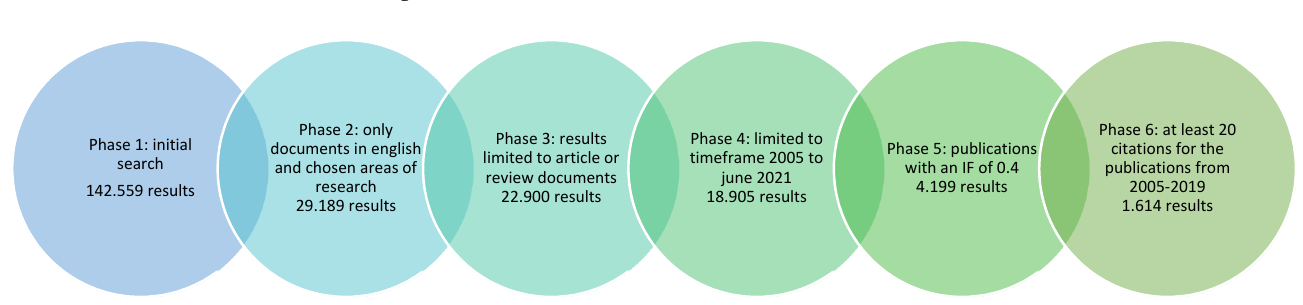
Figure 1. Phases for building the database (Source: own elaboration).